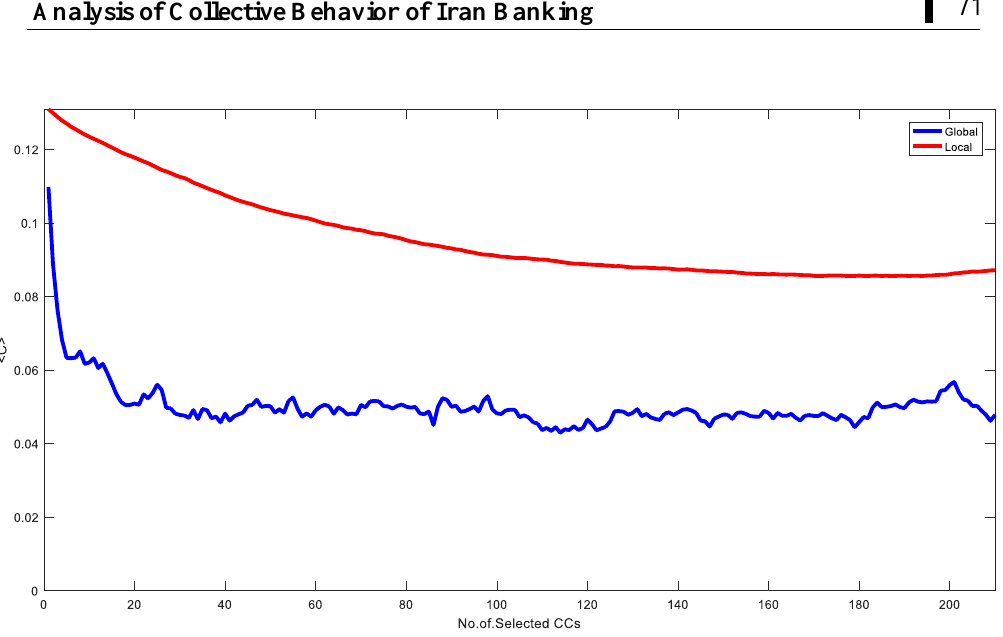
Figure 7. Comparison of mean values of cross-correlation matrix perturbed by local and global perturbations. The X-axis shows the number of correlation coefficients selected to be perturbed. As the number of perturbed correlation coefficients increases, the mean values of the correlation coefficients decreases.